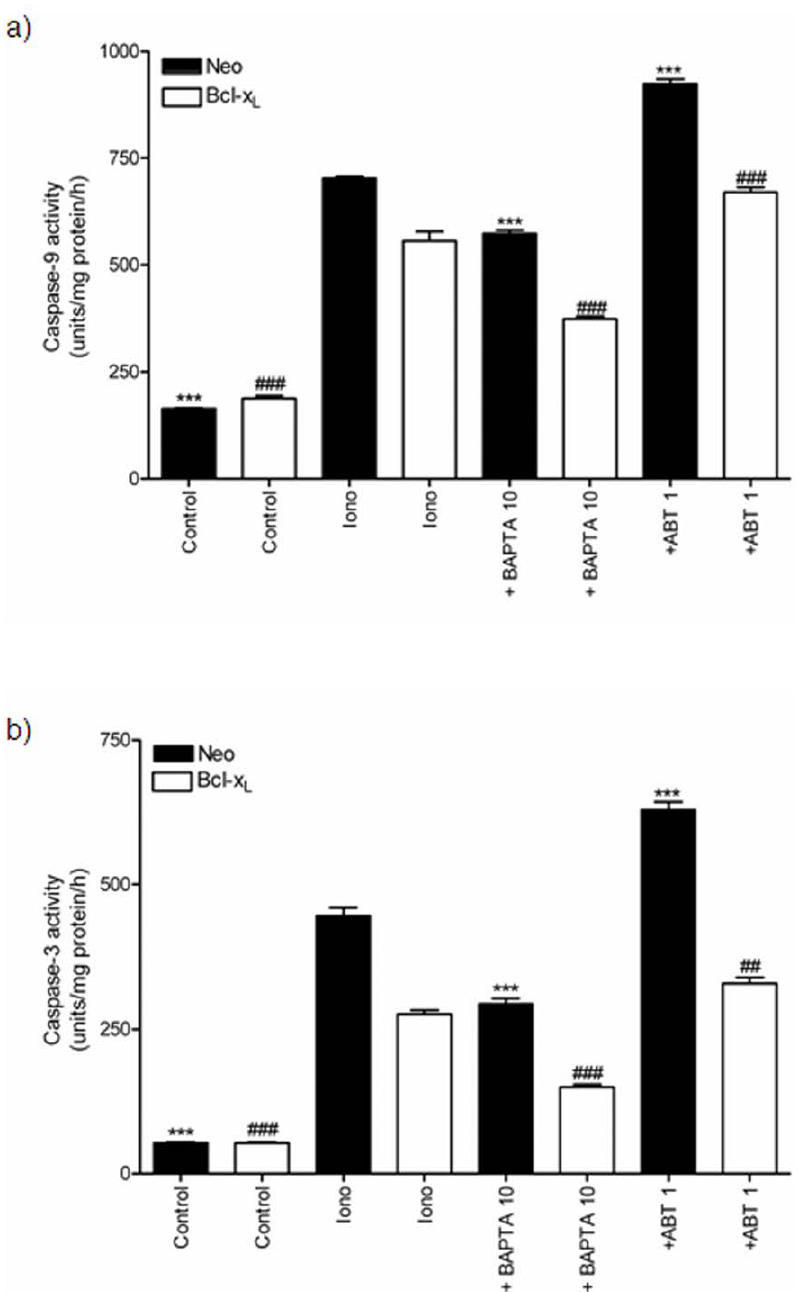
Figure 10. Effect of BAPTA-AM and ABT-737 on ionomycin-induced caspasas activation. a) Caspase-9 activity measured in total lysates obtained from SH-SY5Y/Neo (black bars) and SH-SY5Y/Bcl-x L (white bars) cells treated with vehicle or Ionomycin (2 m M; Iono) in the presence or absence of BAPTA-AM 10 m M ( + BAPTA 10) or ABT-737 1 m M ( + ABT 1) for 6 hours. Data represent mean 6 S.E.M. of 12 experiments. ***p , 0.001 as compared to Ionomycin-treated SH-SY5Y/Neo cells. ### p , 0.001 as compared to Ionomycin-treated SH-SY5Y/ Bcl-x L cells. b) Caspase-3 activity measured in total lysates obtained from SH-SY5Y/Neo (black bars) and SH-SY5Y/Bcl-x L (white bars) cells treated with vehicle or Ionomycin (2 m M; Iono) in the presence or absence of BAPTA-AM 10 m M ( + BAPTA 10) or ABT-737 1 m M ( + ABT 1) for 6 hours. Data represent mean 6 S.E.M. of 12 experiments. ***p , 0.001 as compared to Ionomycin-treated SH-SY5Y/Neo cells. ## p , 0.01, ### p , 0.001 as compared to Ionomycin-treated SH- SY5Y/ Bcl-x L cells.